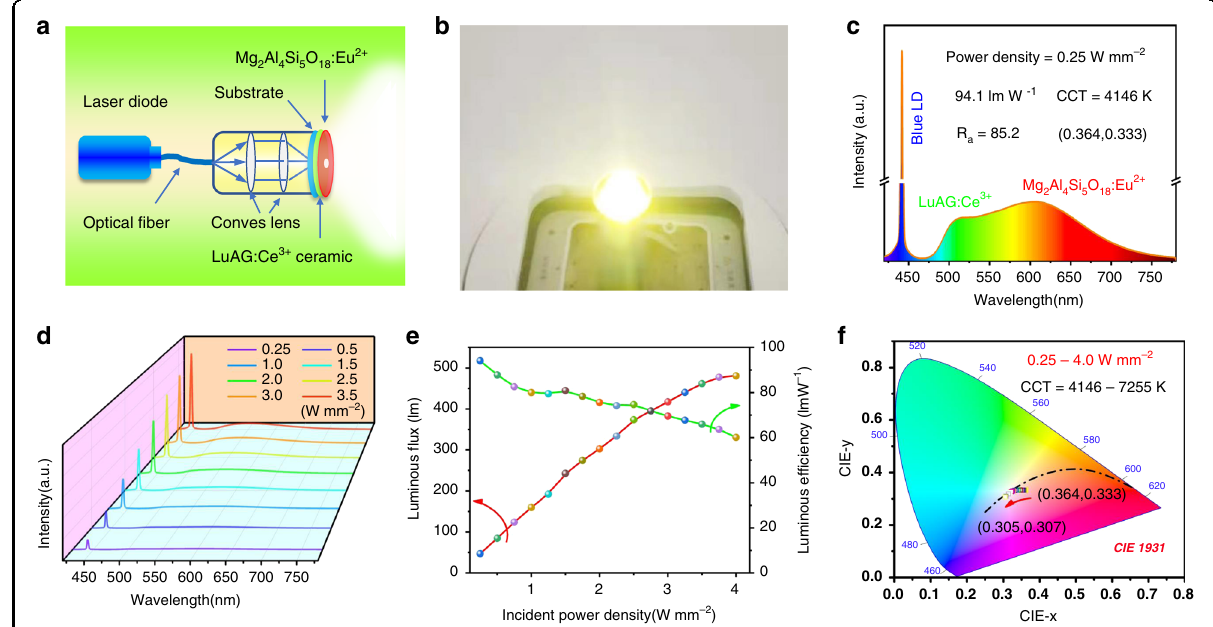
Fig. 6 Photoelectric properties of the LD driven white lighting device. a Schematic illustration of the construction of blue laser driven white light device. b The photograph of the constructed laser driven white light taken under its operation. c The emission spectra of the constructed laser driven light device under the incident power density of 0.25 W mm − 2 . Incident power density-dependent d emission spectra, e luminous fl ux and luminous ef fi ciency, f CIE coordinates of the laser driven lighting